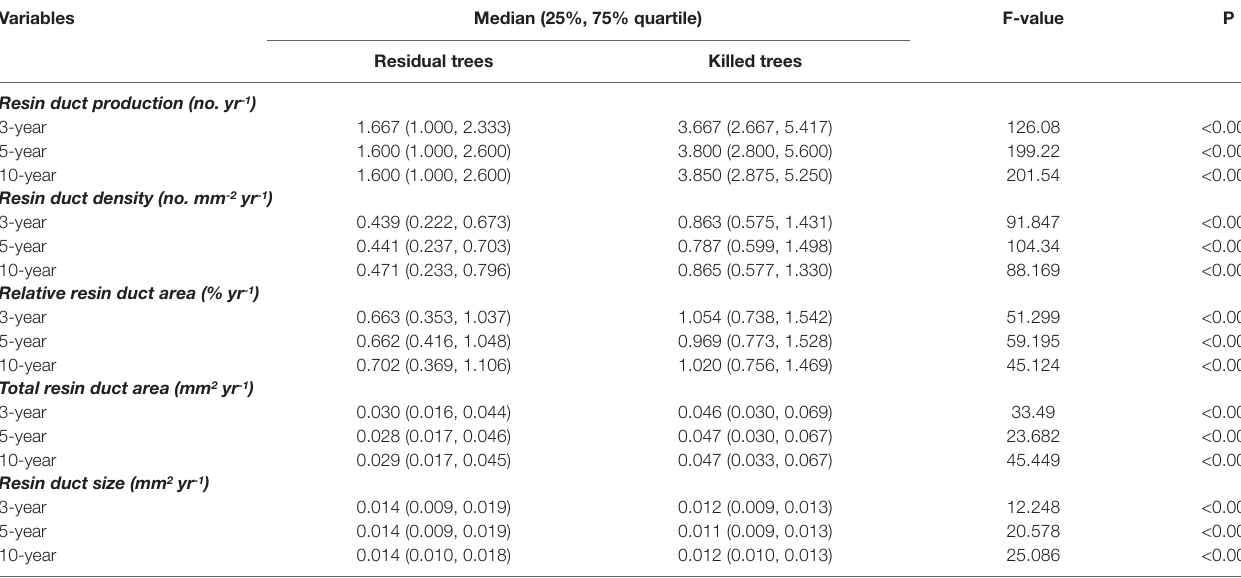
Resin duct characteristics were log-transformed to stabilize the normality and homogeneity of variance of model residuals.